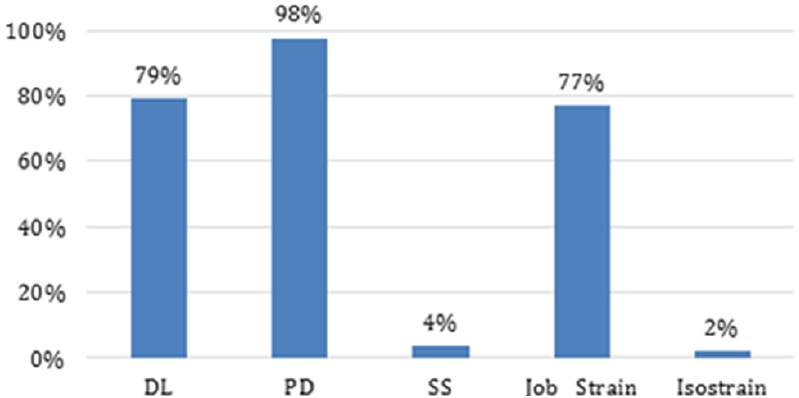
Fig. 1. Prevalence of pathological dimensions according to the Karasek